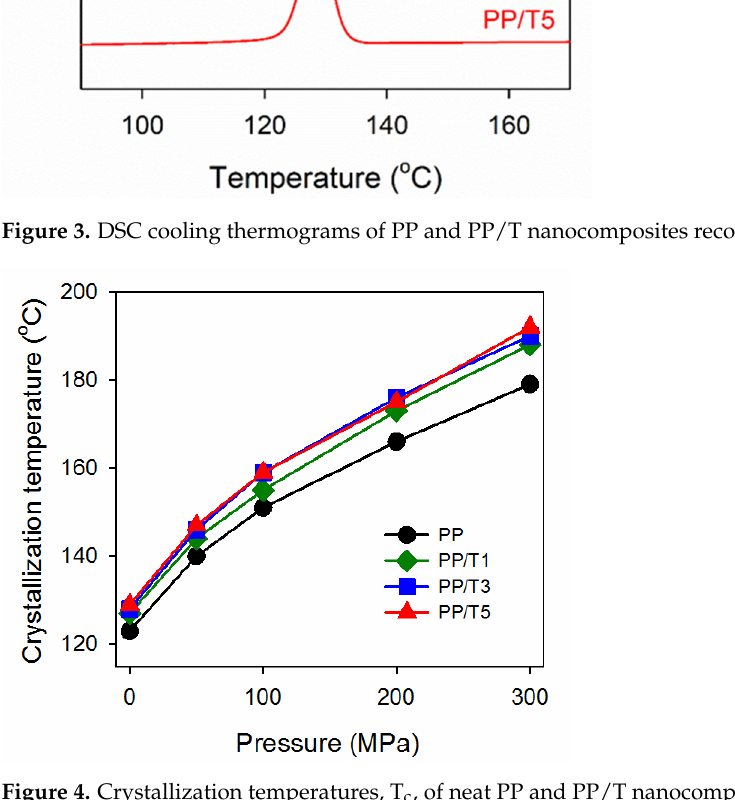
Figure 5. PLM micrographs of thin sections PP, PP/T1, and PP/T5 crystallized during cooling under various pressures. Determination of the crystallographic modification of the crystals formed during cooling under various pressures was possible by WAXD. The analysis of the phase con- tents can take advantage of intensities of the (130) α peak typical of the α -phase and (117) γ